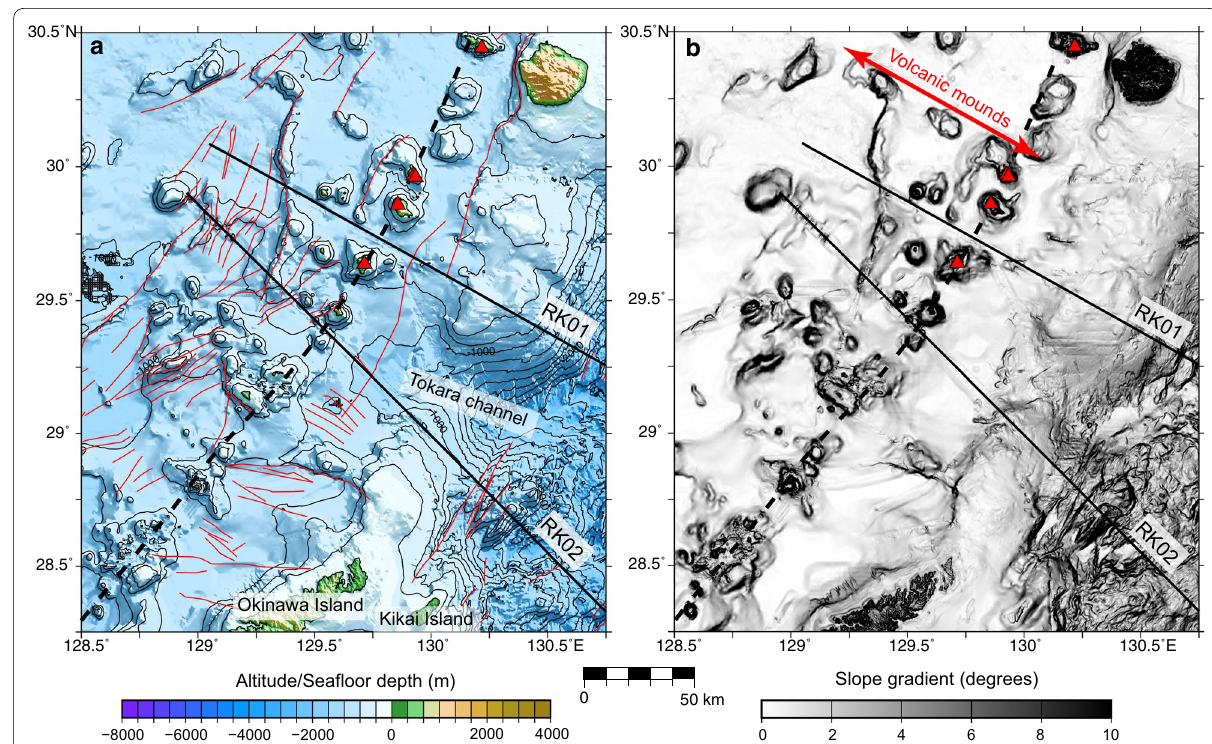
Fig. 2 a Bathymetric map focusing on the across-arc depression of the Tokara Channel and ( b ) its slope gradients. a Depth contours are drawn every 250 m. Black lines indicate the location of the MCS profiles. Red triangles denote active volcanoes (Japan Meteorological Agency 2013). Most of the faults reported by The Headquarters for Earthquake Research Promotion (2016) (red curves) are recognized as normal faults with NE–SW- trending, but we find that the faulting style is spatially more heterogeneous (see text for discussion). The slope gradient in b was calculated using tools from the GMT software (Wessel and Smith 1998). Note that numerous circular mounds indicating subaerial/submarine volcanic ridges are developed on the back-arc side of the volcanic